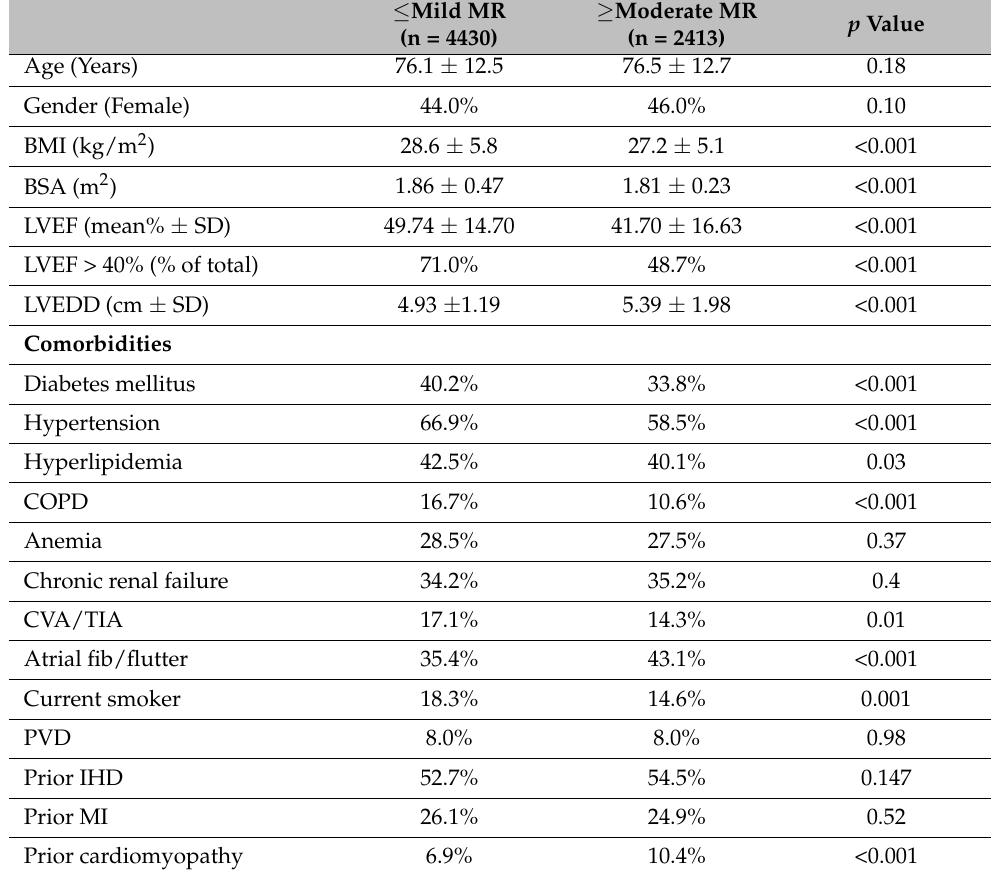
Table 1. Baseline clinical characteristics according to MR